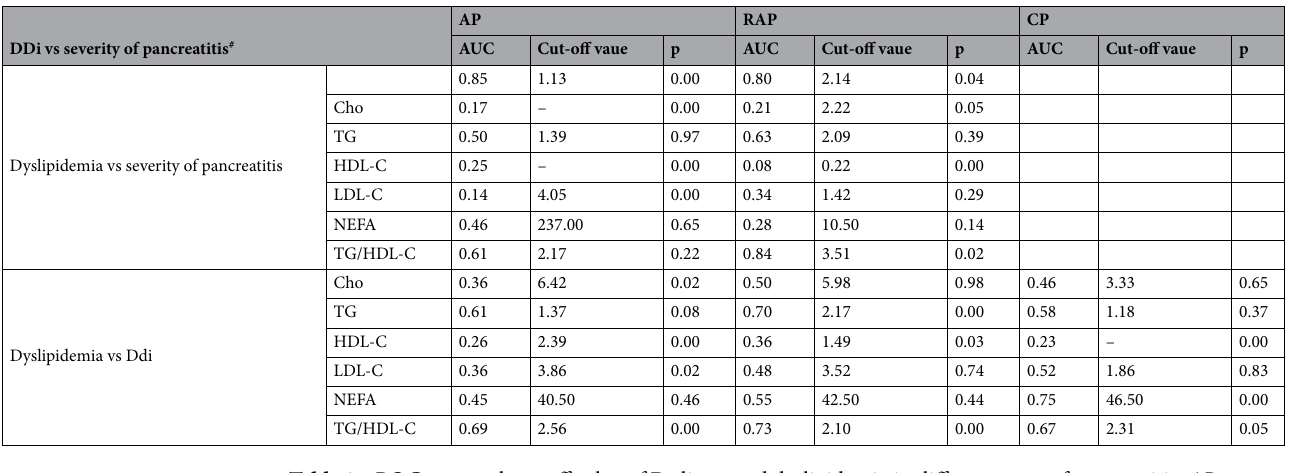
Table 3. ROC cure and cut-off value of D-dimer and dyslipidemia in different types of pancreatitis. AP acute pancreatitis, RAP recurrent acute pancreatitis, CP chronic pancreatitis, TG triglyceride, Cho cholesterol, LDL-C low-density lipoprotein cholesterol, HDL-C high-density lipoprotein cholesterol, NEFA non-esterified fatty acids, AUC area under the receiver-operating characteristic curve. # The severity of pancreatitis was subdivided into MAP and non-MAP